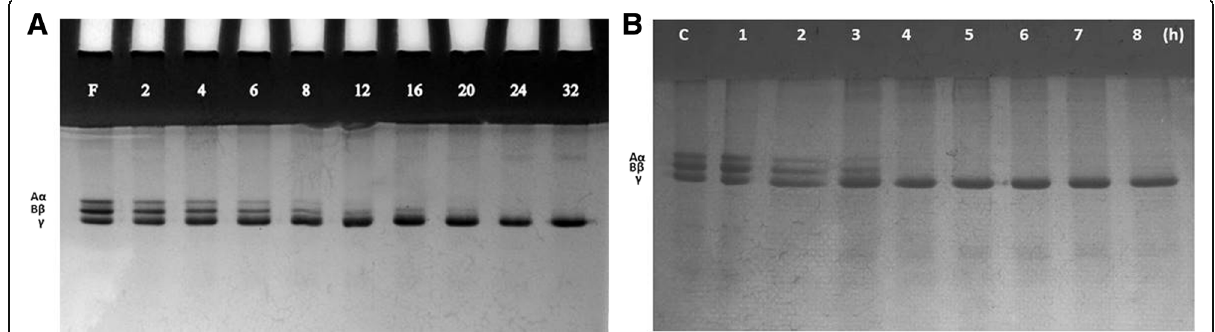
Fig. 4 Dose- and time-dependent fibrinogenolysis by AiP1: A Lane F is fibrinogen incubated with 0.85% saline (negative control); other lanes represent the dose of AiP1 (in μ g) incubated with fibrinogen. B Lane C is fibrinogen incubated with 0.85% saline (negative control); other lanes represent the time period of AiP1 (10 μ g) incubated with fibrinogen at 37 °C